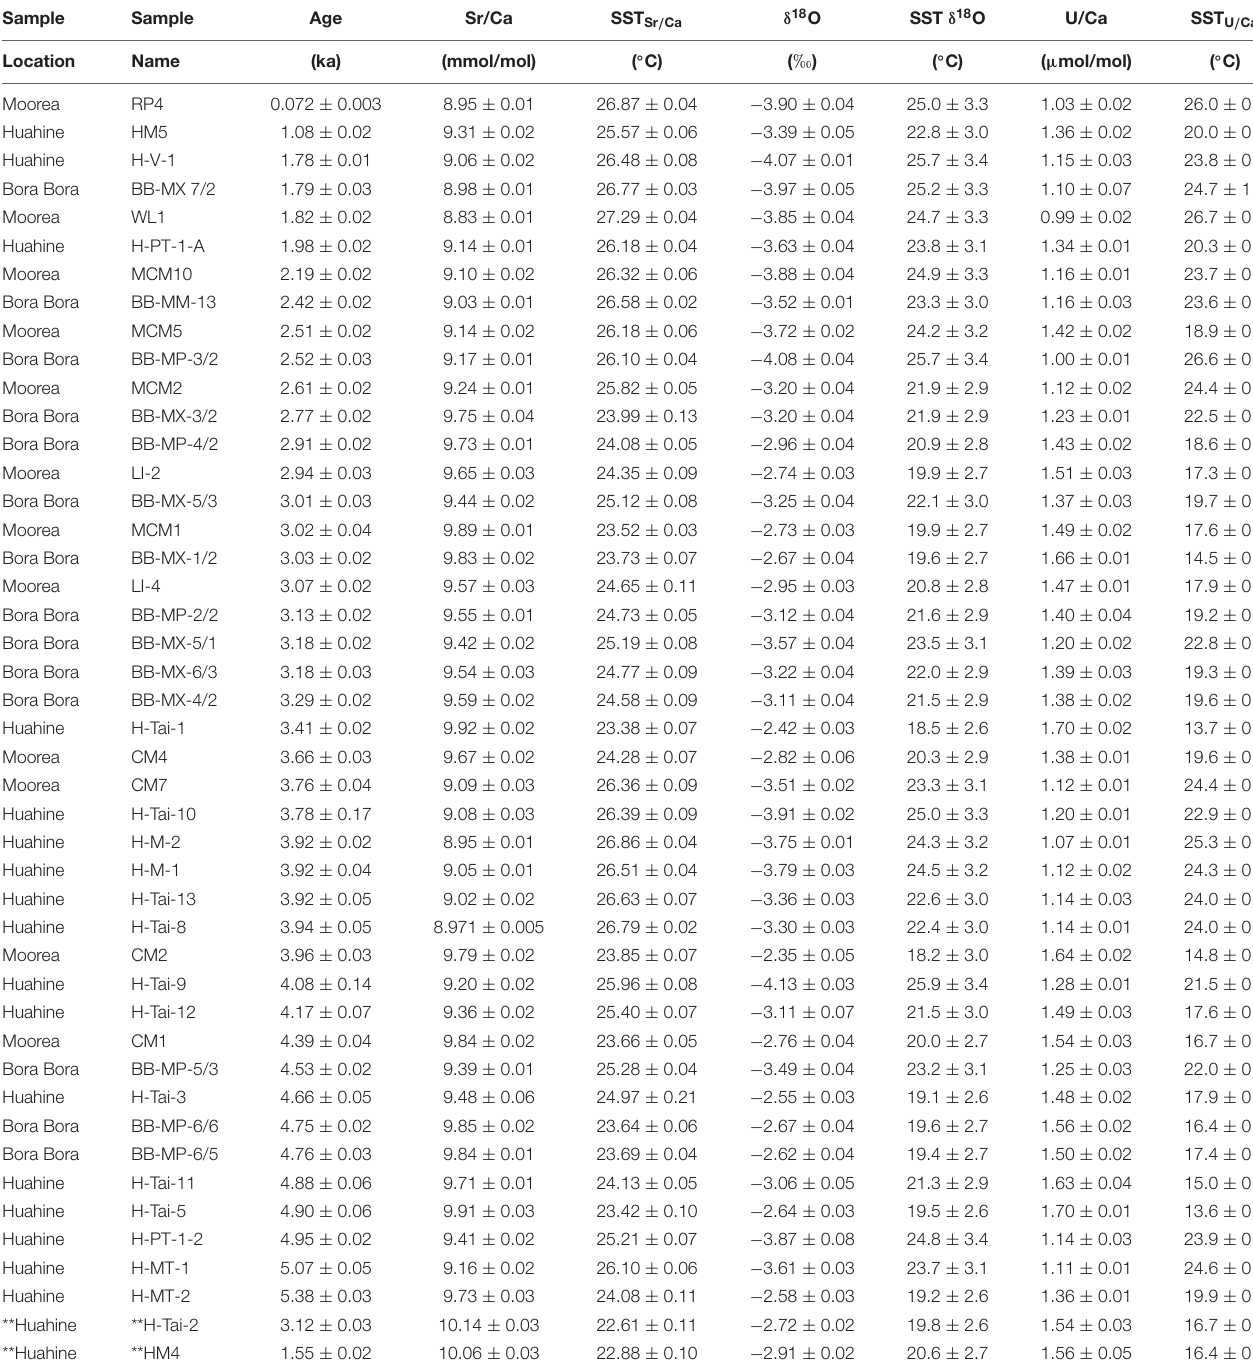
TABLE 1 | Sampling locations, age (ka), Sr/Ca ratios (mmol/mol), δ 18 O